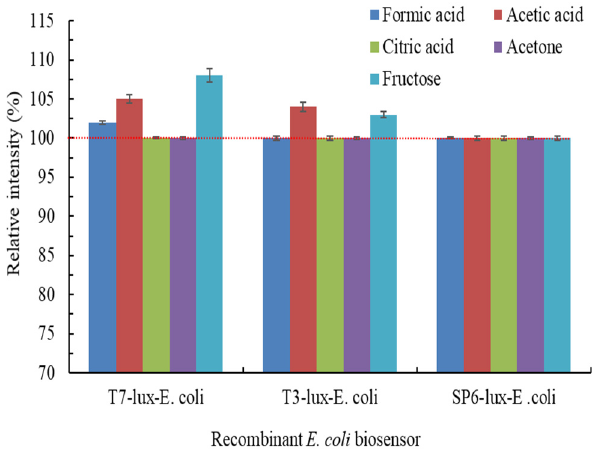
Figure 4. Effects of coexisting carbon sources at 300 µ M on luminescence intensities of three recombinant E. coli biosensors induced with 0.5 mg/L Cr(VI) for 1.5 h (T7-lux- E. coli ), 1 h (T3-lux- E. coli ), and 0.5 h (SP6-lux- E. coli ).